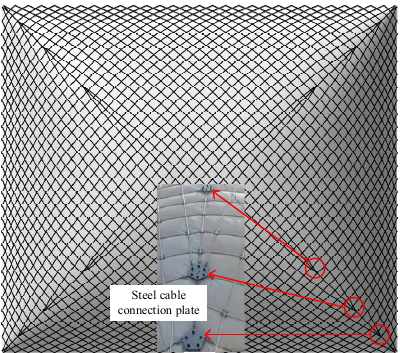
Figure 6. Original model.